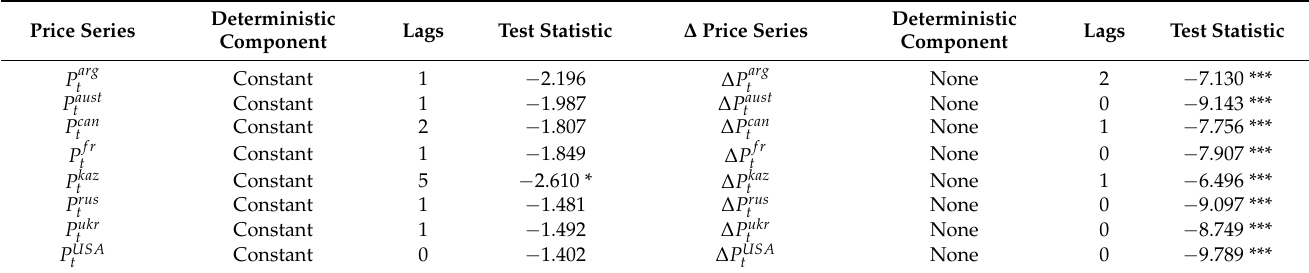
Table 2. Augmented Dickey–Fuller test for prices in levels and first